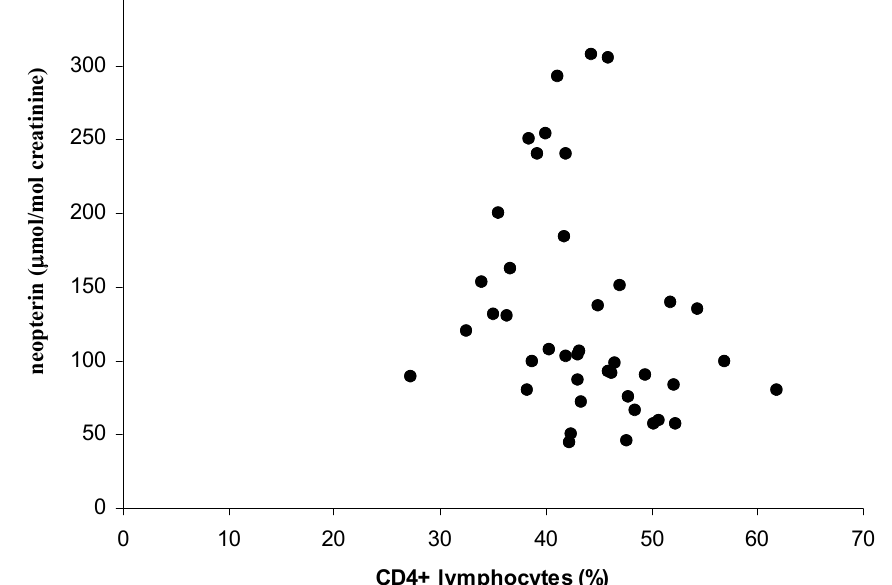
Figure 2. Correlation between urinary neopterin and the relative numbers of CD3 + CD4 + lymphocytes before the start of therapy (r = - 0.411, p < s